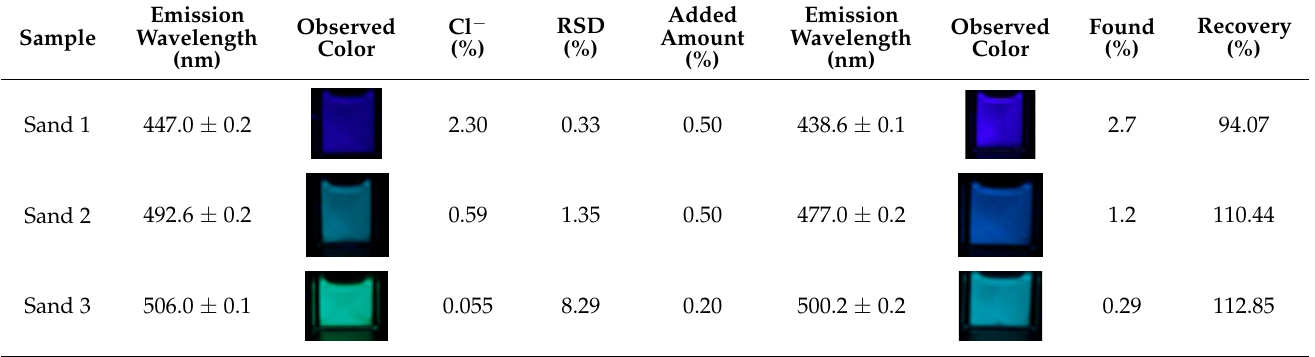
Table 1. Determination of Cl − in sand samples and their recoveries.